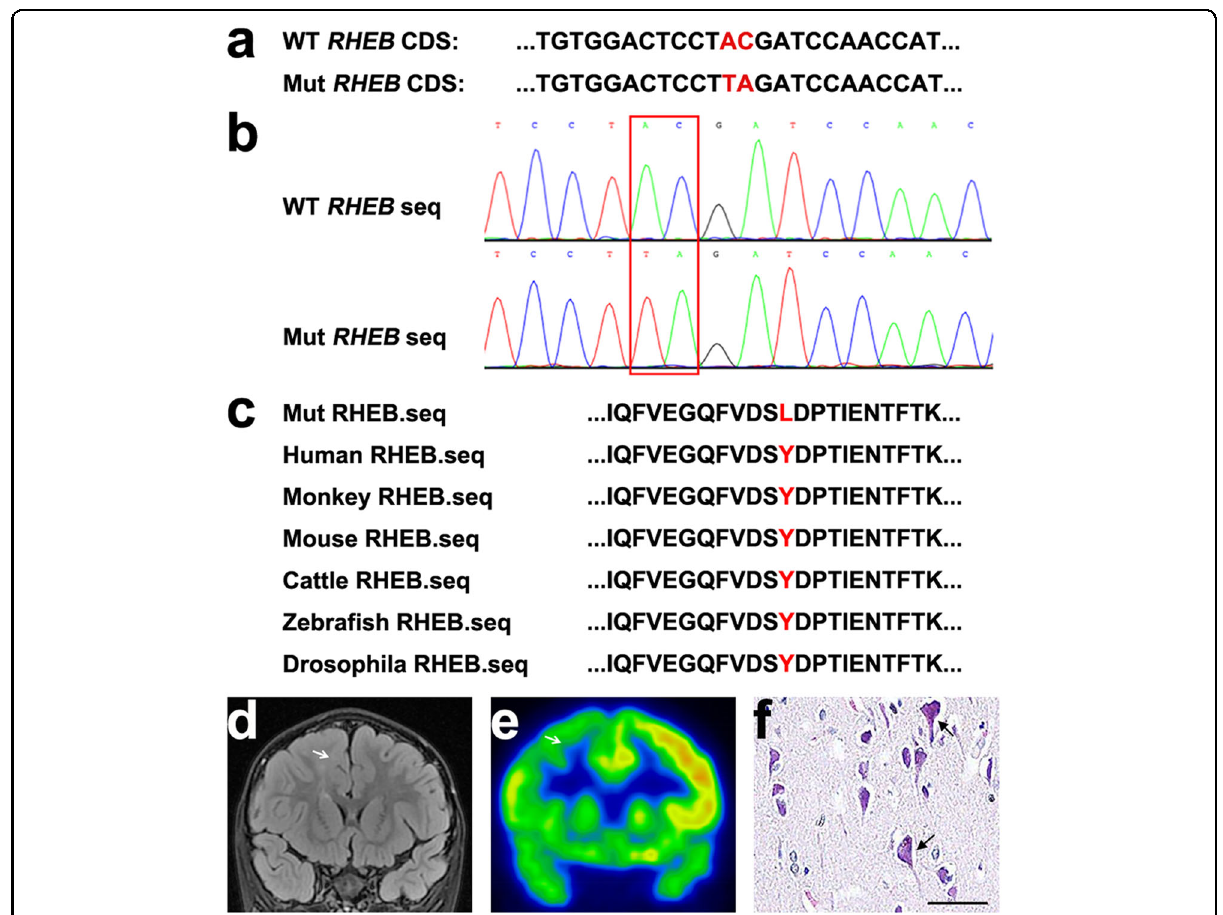
Fig. 1 Identi fi cation of a brain somatic RHEB doublet mutation in a patient with FCDII. a Two adjacent RHEB mutations (Mut) identi fi ed by WES were compared to wild-type (WT) RHEB . The mutation sites are highlighted in red. b PCR products ampli fi ed from DNA derived from patient lesion tissue were subjected to TA cloning. Individual T-vector clones were subjected to Sanger sequencing. The sequencing results of the WT and Mut RHEB clones were compared, and the mutation sites are highlighted in red boxes. c The RHEB protein regions from different species spanning the mutation site were aligned for comparison. The mutation site is highlighted in red. Brain magnetic resonance imaging ( d ) and positron emission tomography scan ( e ) of the patient carrying the RHEB doublet mutation. The white arrows indicate lesion regions. f Hematoxylin-eosin staining of resected lesion tissue of the RHEB doublet mutation carrier. Abnormal cells are indicated with black arrows. Scale bar: 50 μ